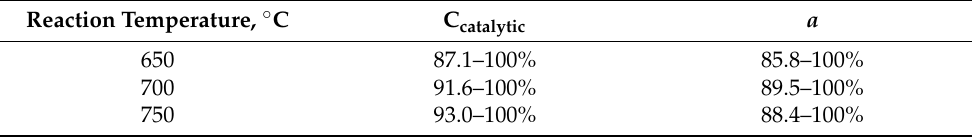
Table 1. Value ranges of C catalytic and a in pentene cracking over H-ZSM-5 at 650–750 °C and 83 h − 1 . Reaction Temperature, °C